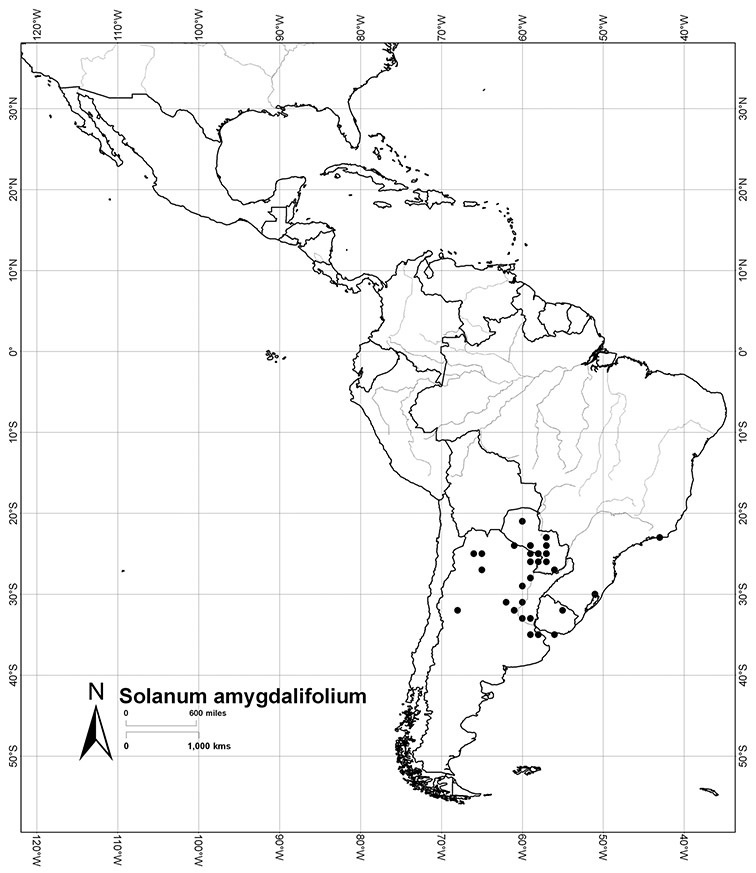
Distribution of Solanum amygdalifolium Steud.